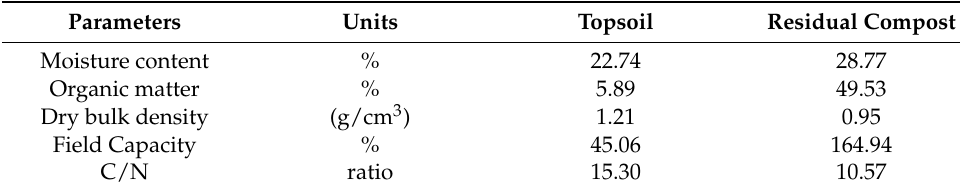
Figure 1. Schematic diagram of the constructed columns. Table 1. Characteristics of column construction materials.